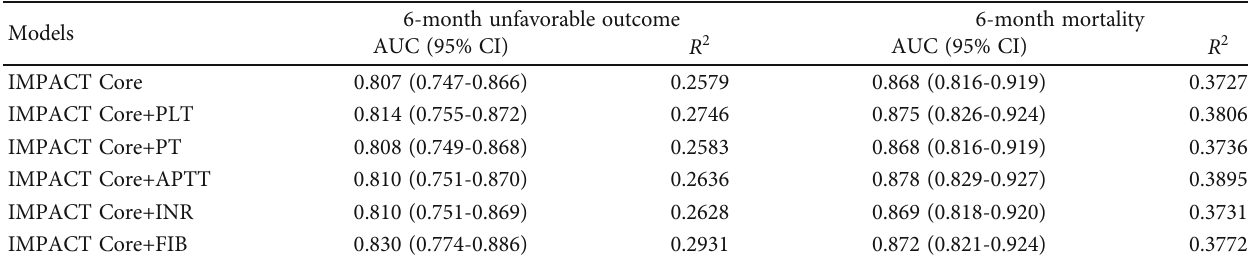
Table 4: AUC of IMPACT and